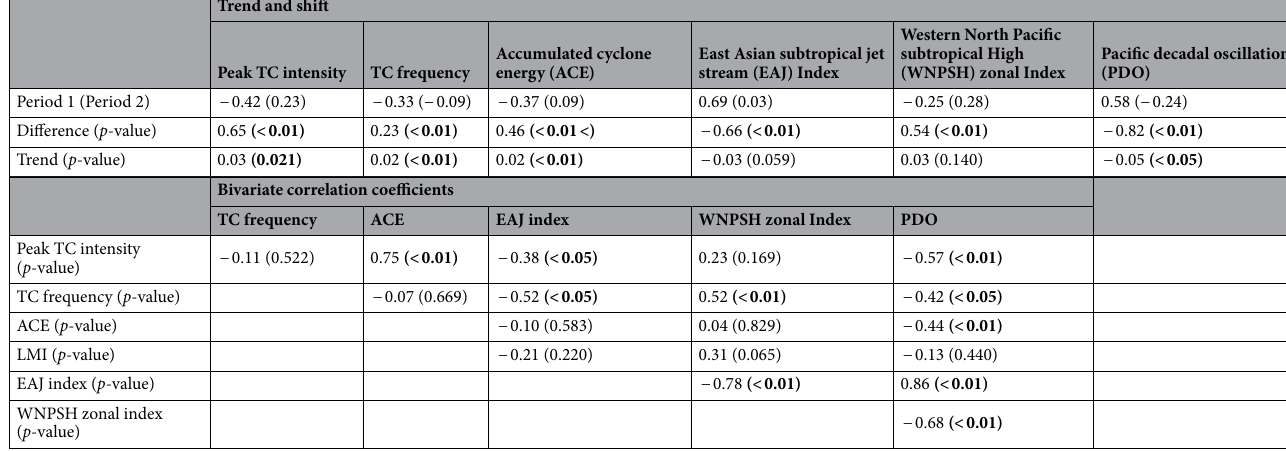
Table 1. Shift, trend, and correlation of indicated TC metrics and selected climate indices during the mature boreal autumn, respectively. p -values in bold are significant at p < 0.05 confidence